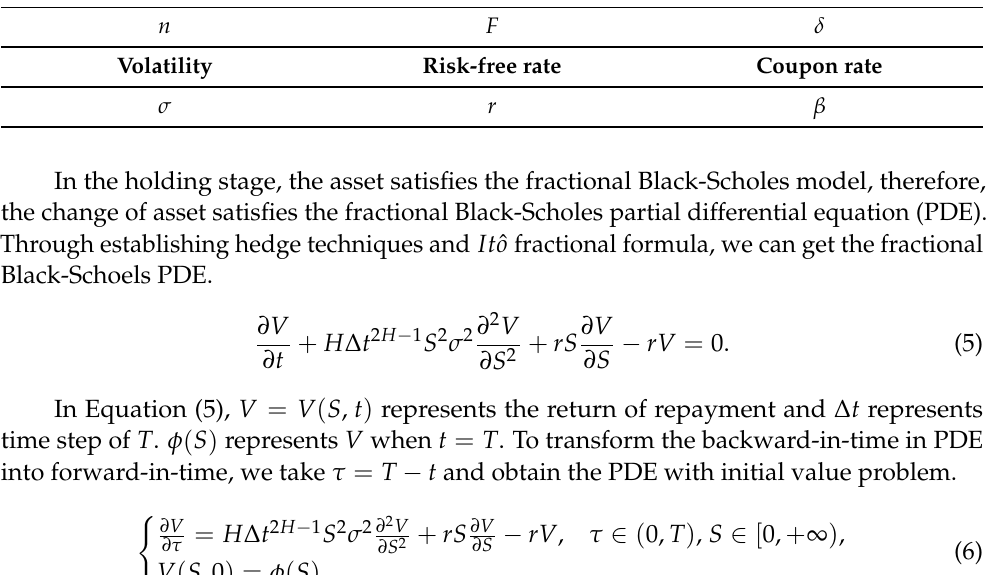
Table 1. Parasmeters of fractional step-down ELS. Hurst Exponent Strike Price Underlying Asset Price H K S Maturity Knock-in-barrier Dummy T D d Numer of observation dates Face value Strike date n F δ Volatility Risk-free rate Coupon rate σ r